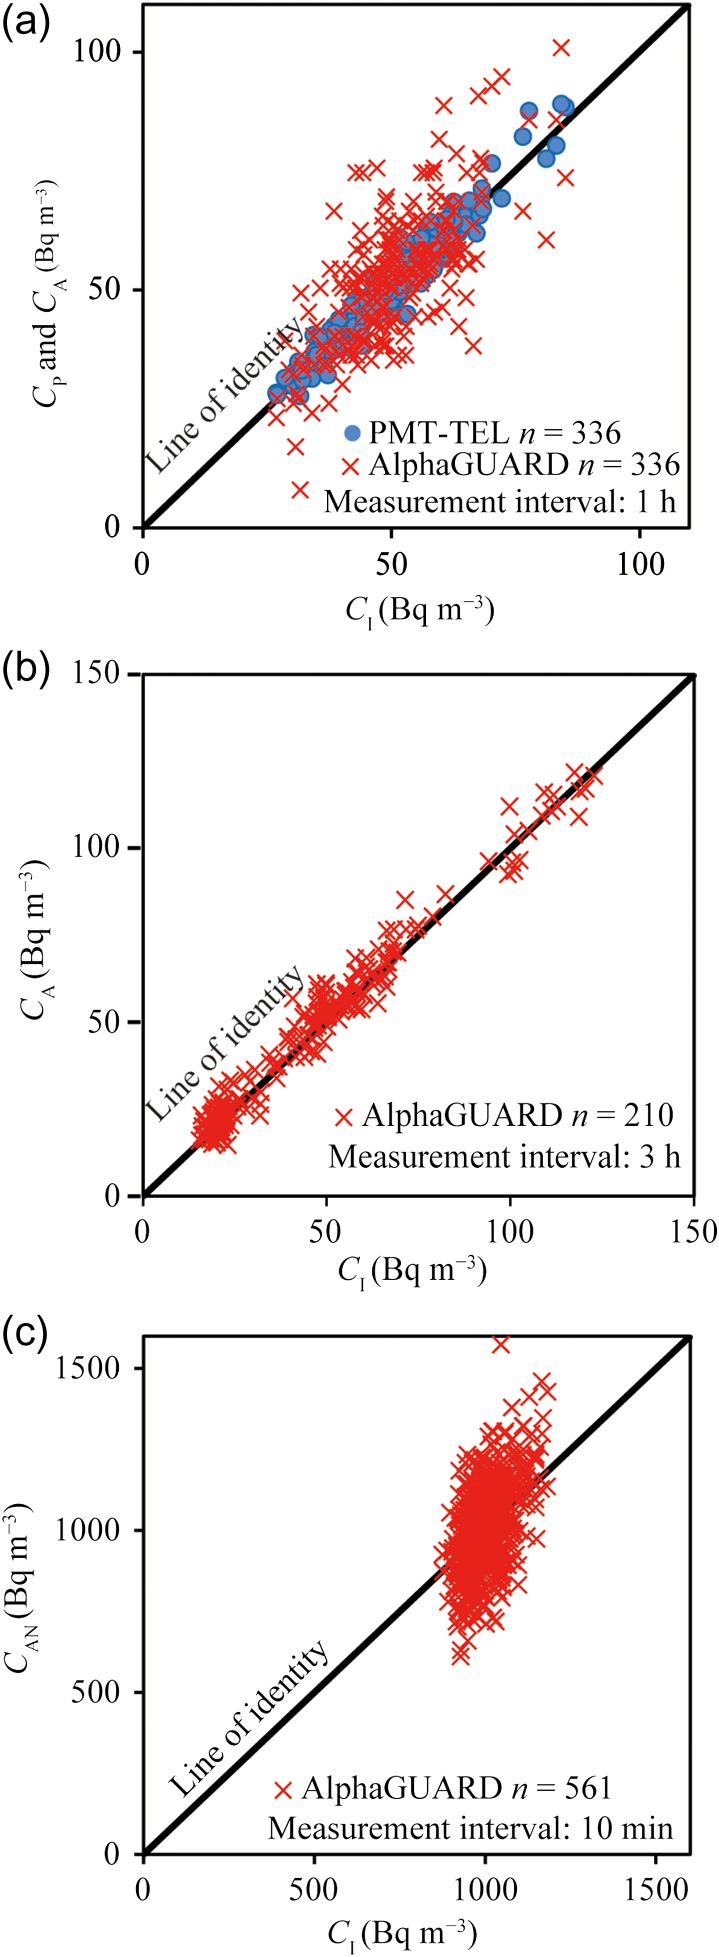
Radon concentrations obtained by the reference monitor (DGM-101) vs. test monitors. The solid black line is the identity line. (a) Step 1: the DGM-101 vs. the PMT-TEL and KPU AlphaGUARD. (b) Step 2: the DGM-101 vs. the KPU AlphaGUARD. (c) Step 3: the DGM-101 vs. the NIRS AlphaGUARD.